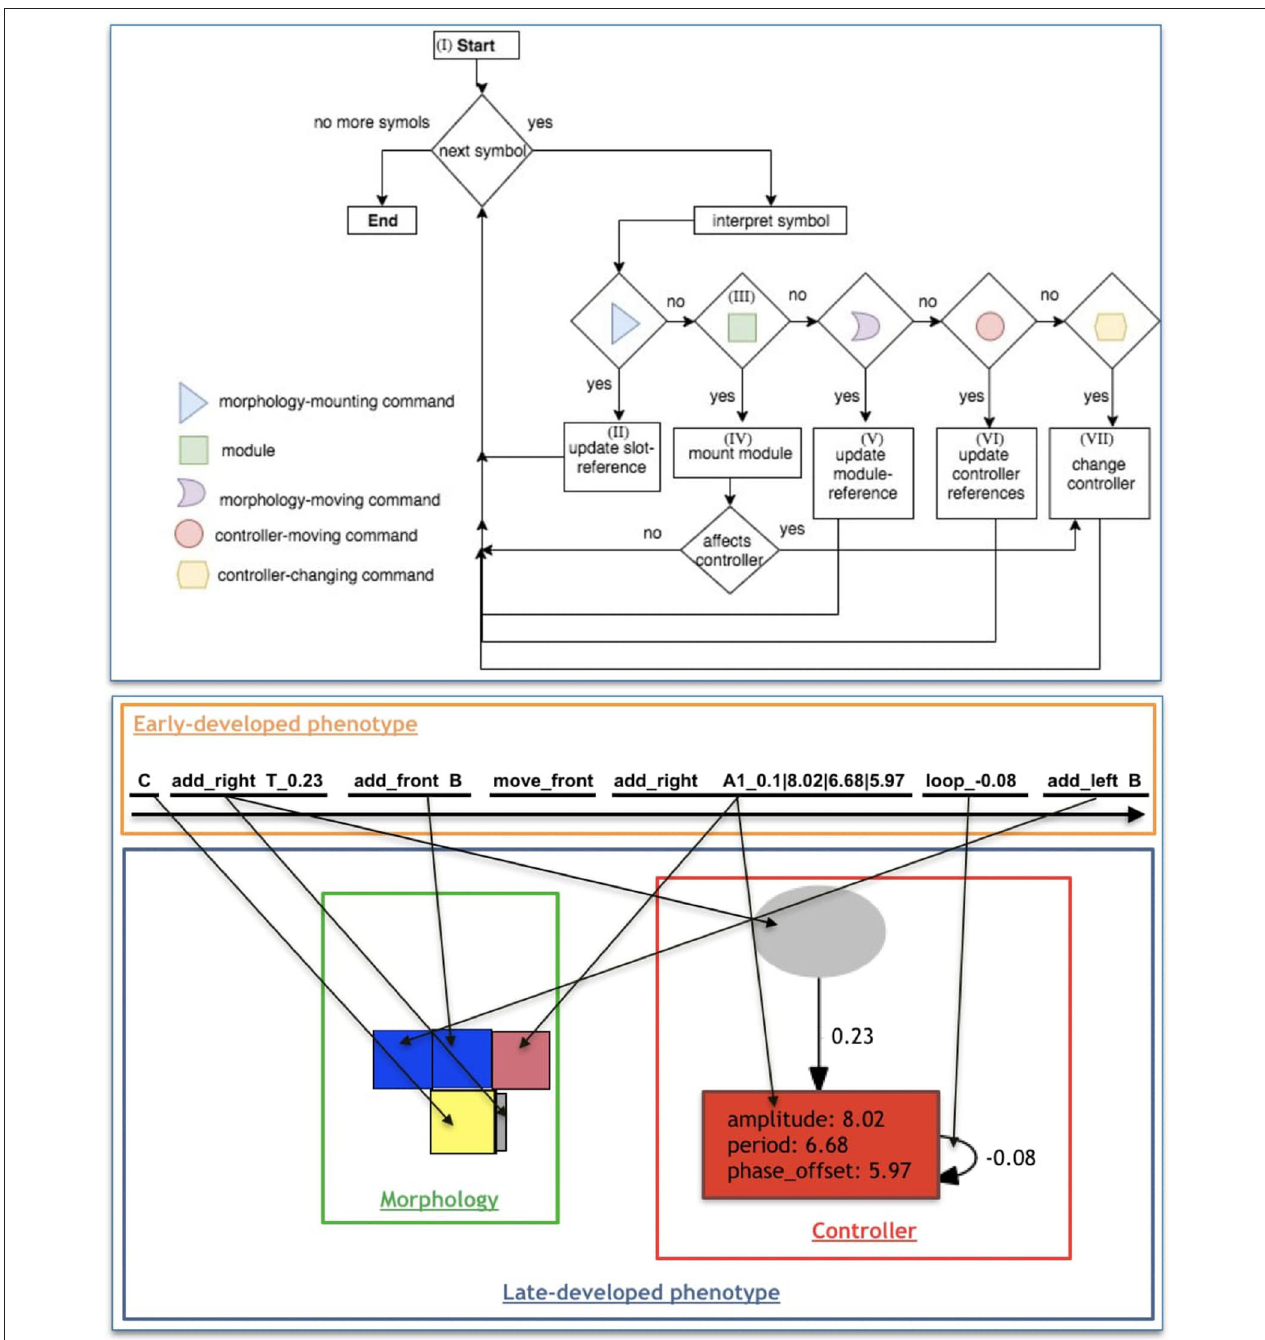
FIGURE 5 | (Top) Flow-chart of the late-development process. From the left to right of the string, each symbol of the early-developed phenotype (string) goes through this process, being interpreted and developed (or not expressed). (Bottom) Illustration of decoding an early-developed phenotype into a late-developed phenotype with morphology and controller. From the left to right of the string, symbols are interpreted and developed, making incremental changes to the phenotype. An arrow going from the genotype to the phenotype should be interpreted as the process leading to the creation of the phenotype component pointed at by the arrow after the interpretation of the genotype component at the starting end of the